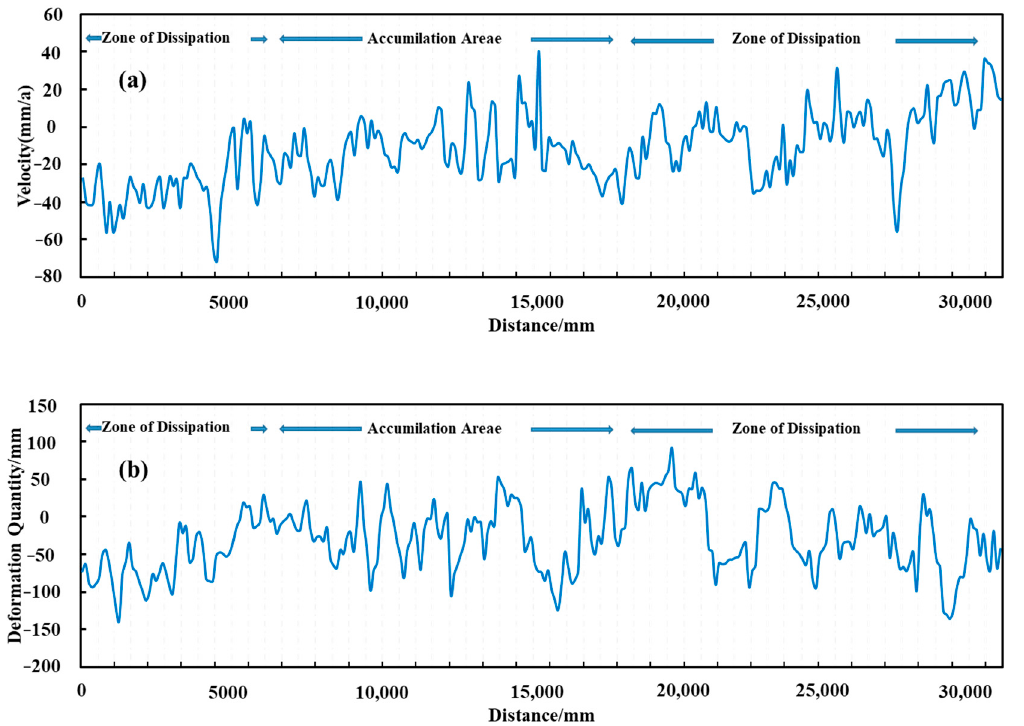
Figure 10. Longitudinal profile deformation characteristics; ( a ) is the longitudinal profile deformation rate, ( b ) is the cumulative deformation variable.